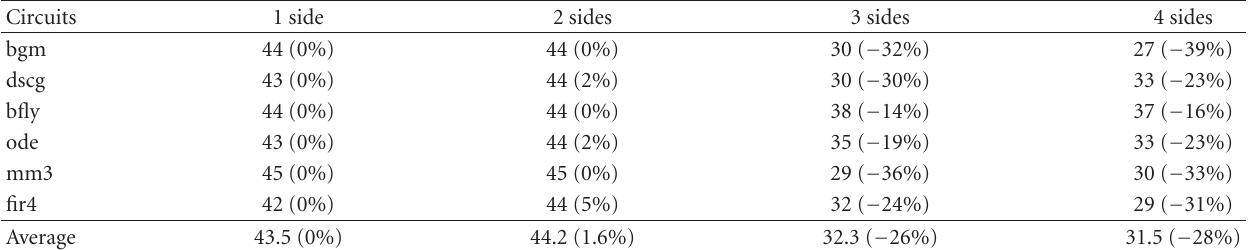
Table 4: Minimum channel width (number of wires) for di ff erent I/O positions for single EB-type FPGA as shown in Figure 5. The percentage shows the deviation from the 1 side result.